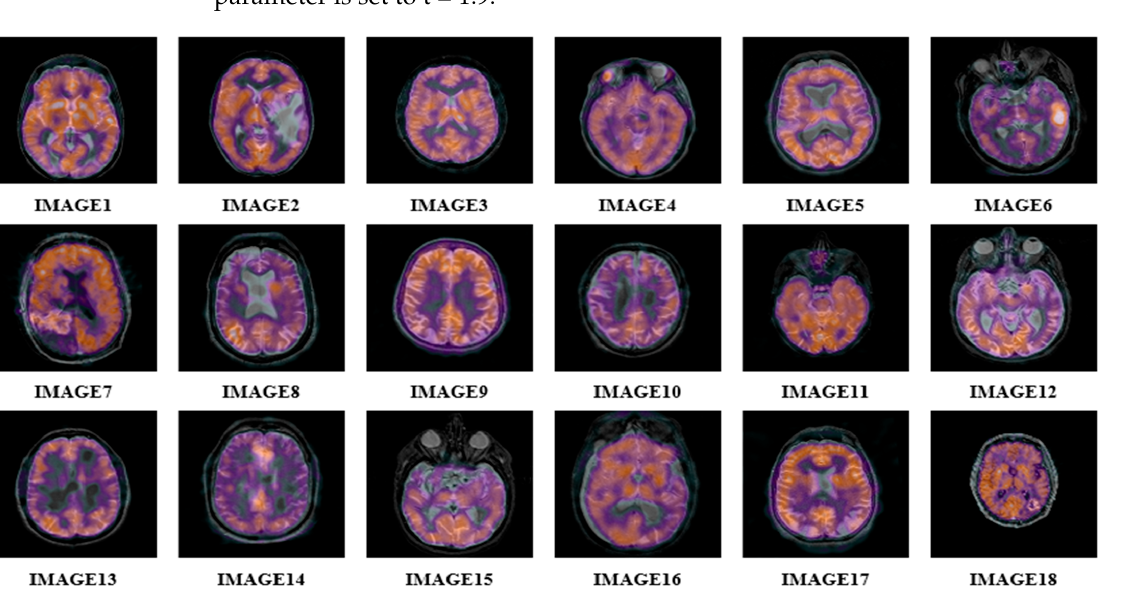
Figure 4. Binary watermarks images. 4.1. Evaluation Metrics The PSNR is used to evaluate the distortion of attacked images, where lower PSNR values reflect a high degree of distortion and vice versa. The PSNR is defined as [41]: (cid:1842)(cid:1845)(cid:1840)(cid:1844)( (cid:1859) (cid:3030) , (cid:1859) (cid:3030)(cid:3050) ) = 10(cid:1864)(cid:1867)(cid:1859) (cid:2869)(cid:2868) 255 (cid:2870) (cid:1839)(cid:1845)(cid:1831)